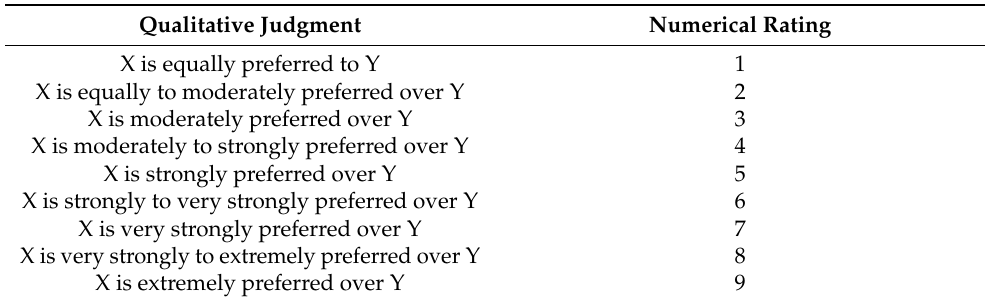
Table 5. Pairwise comparison of item X and item Y. Qualitative Judgment Numerical